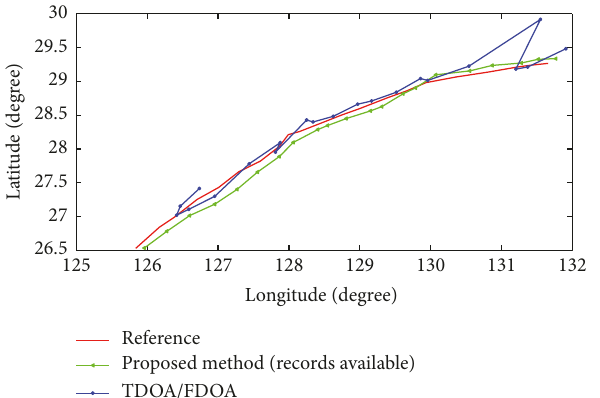
Figure 5: Distance between reference and estimated positions for records availability scenario.